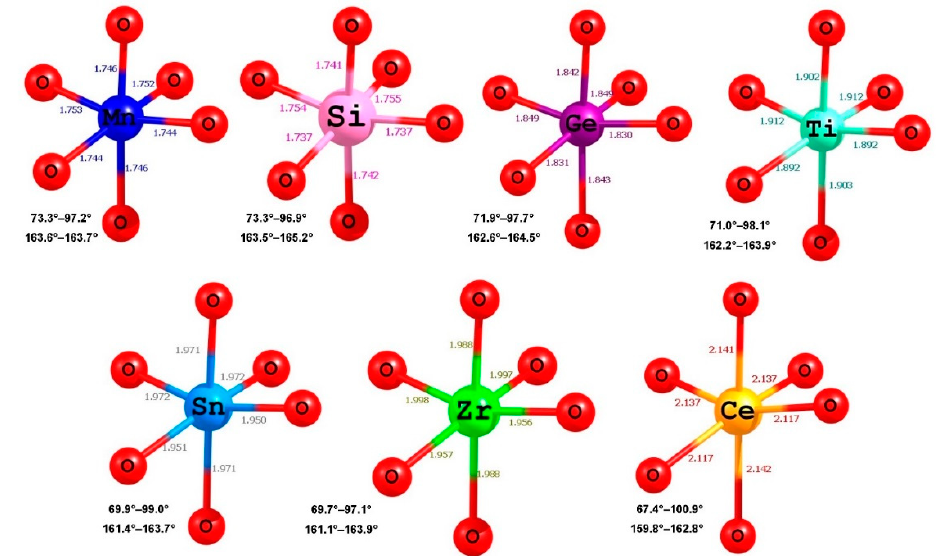
Figure 8. Distorted octahedral MnO 6 units in the relaxed structure of undoped Li 2 MnO 3 and the